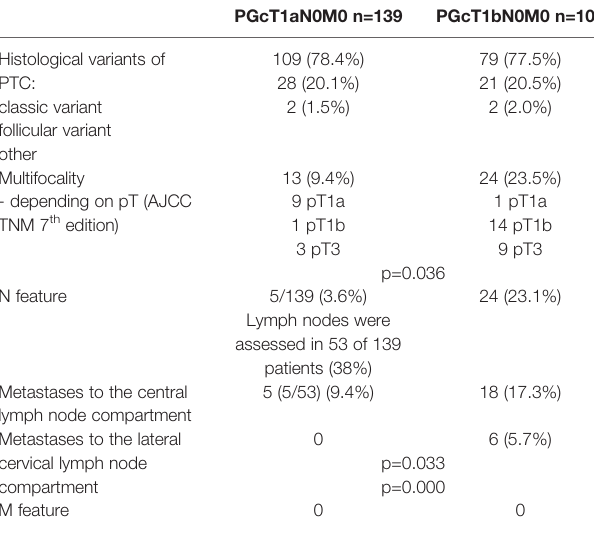
TABLE 5 | Comparison of postoperative advancement (TNM/AJCC 7 th edition) of the disease in the PG